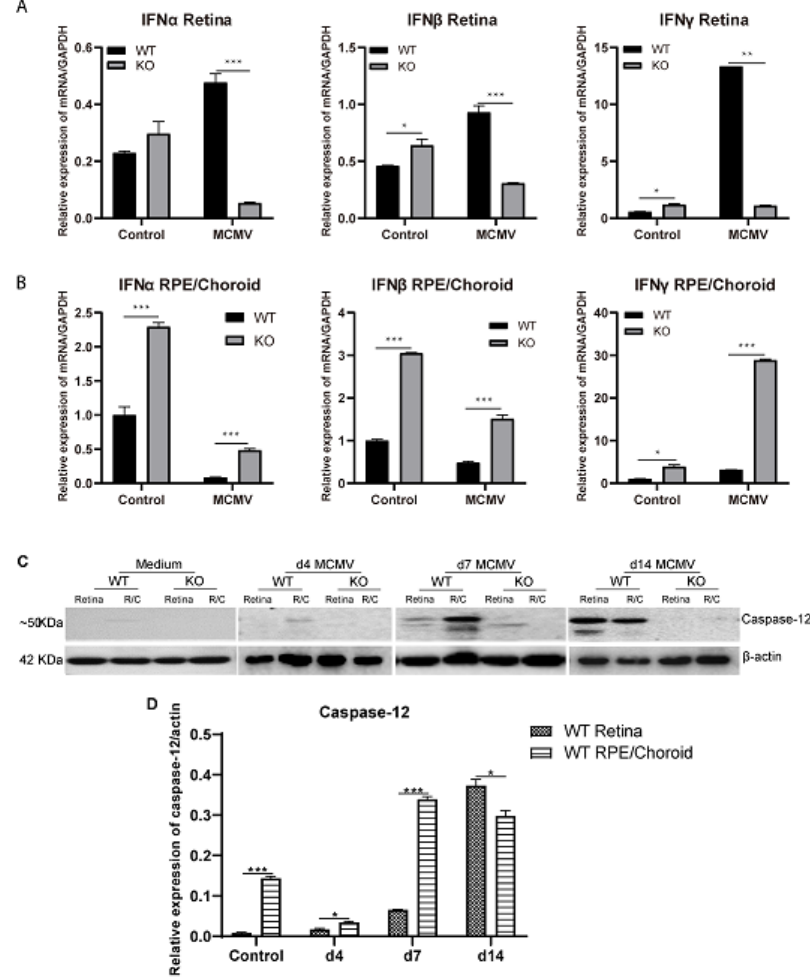
Figure 3. Interferons and caspase-12. ( A , B ) Relative expression levels of mRNA for interferons- α , - β and - γ by real-time RT-PCR in the retina ( A ) or posterior eyecups (RPE/choroid, ( B )) from MCMV-infected eyes of IS WT and KO mice at day 14 p.i. Data are shown as mean ± SEM ( n = 3). * p < 0.05, ** p < 0.01, *** p < 0.001 by 2-tailed t-test. ( C ) Western blot of caspase-12 in retina or posterior eyecups (R/C) from medium-injected and MCMV-injected eyes of IS WT or KO mice at days (d) 4, 7, and 14 p.i. ( n = 3). ( D ) Ratio of full length caspase-12 (~50 KDa) to β -actin. Data are shown as mean ± SEM. * p < 0.05, *** p < 0.001 by 2-tailed t -test.